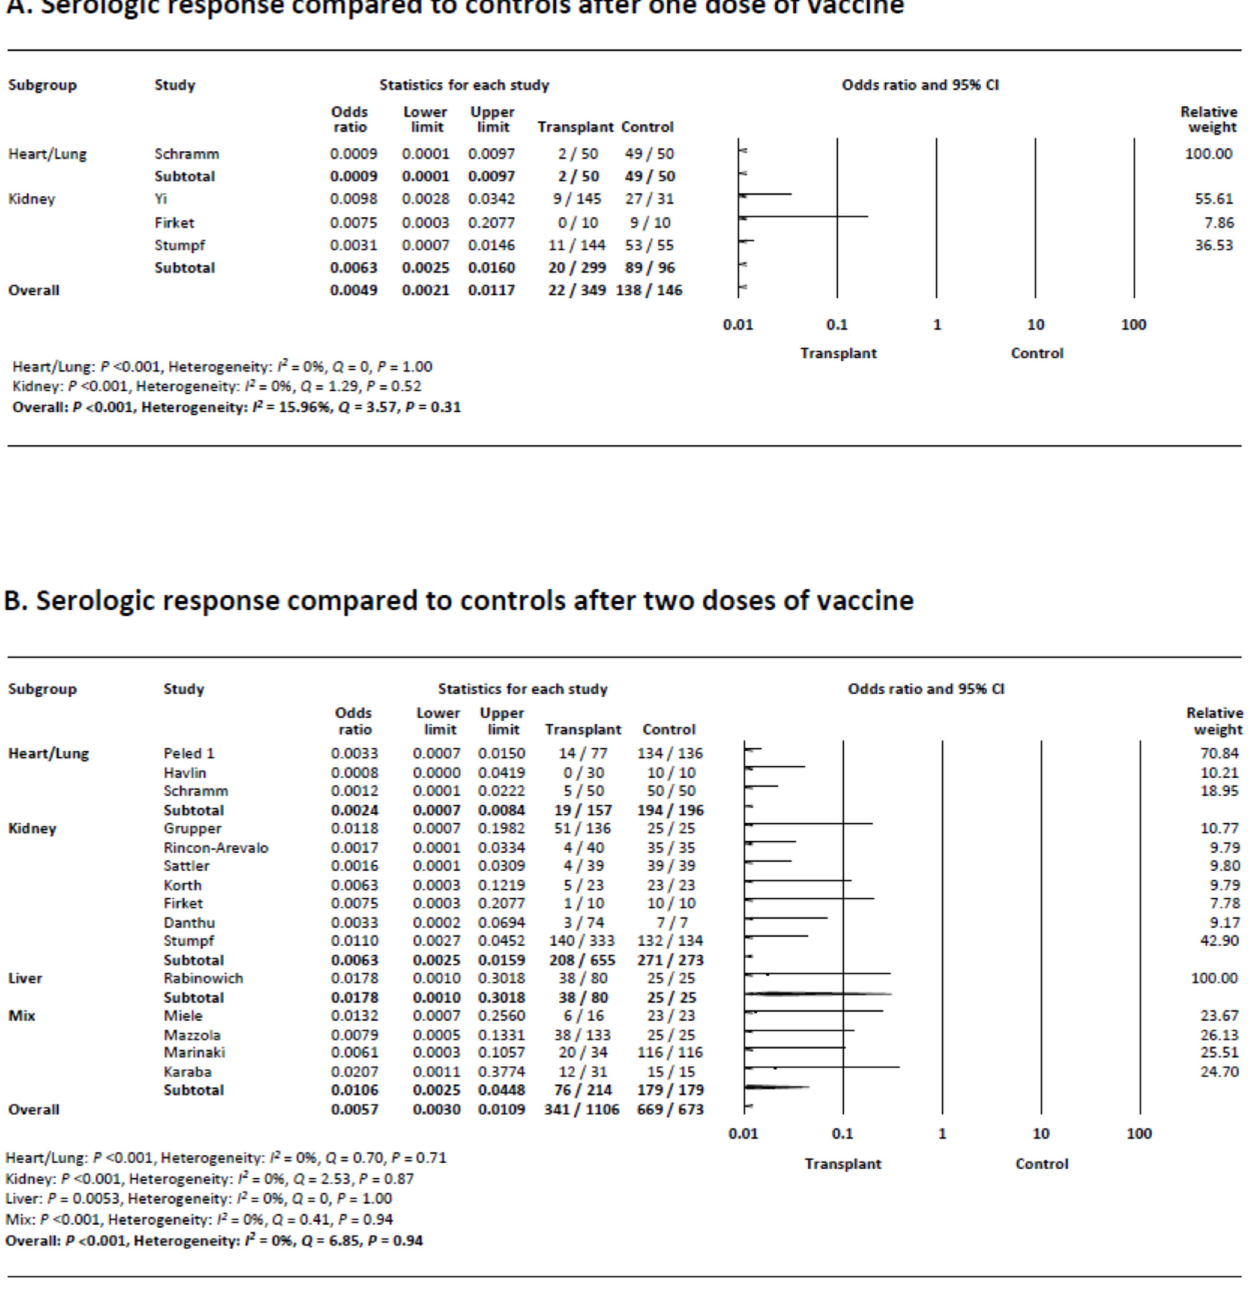
Figure 3. ( A ) Meta-analysis of serological response compared to controls after one dose of vaccine. ( B ) Meta-analysis of serological response compared to controls after two doses of vaccine.